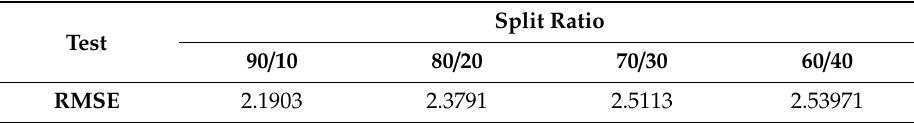
Table 3. RMSE results for various split ratio tests.